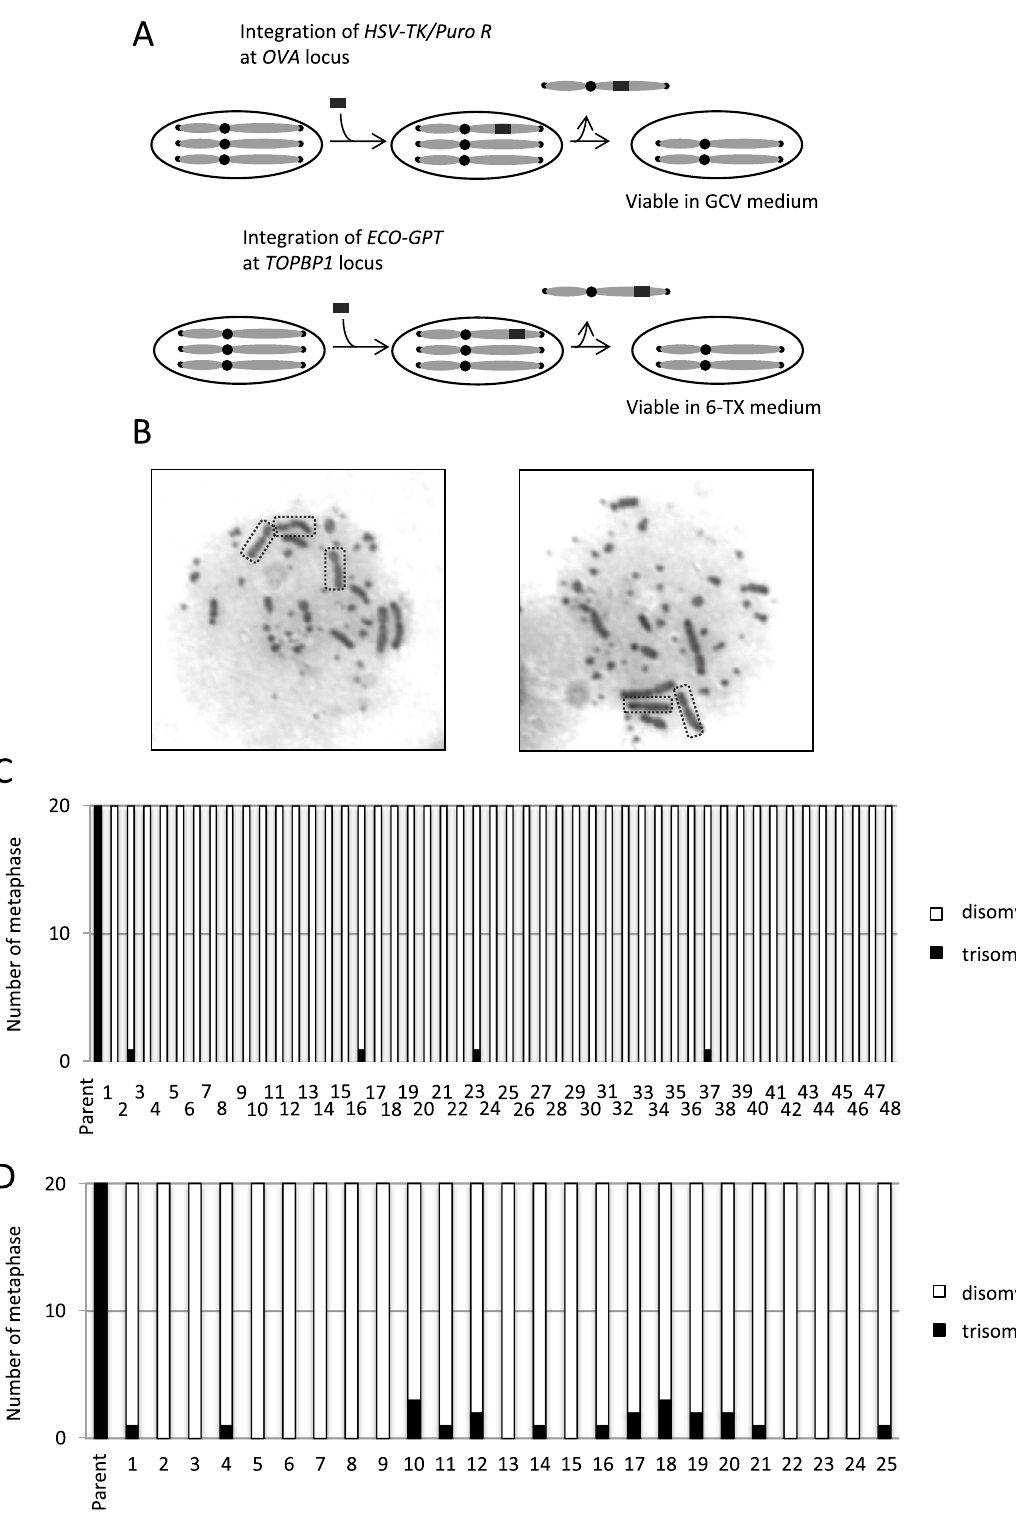
Figure 1. Correction of chromosome 2 trisomy in DT40 cells. ( A ) Schematic representation of trisomy correction with negative-selection markers. A negative-selection marker ( HSV-TK or ECO-GPT ) was integrated at OVA or TOPBP1 locus on chromosome 2 by homologous recombination. After subsequent drug selection, the cells which lost the chromosome containing negative selection marker survived. ( B ) Representative images of metaphase spreads of chromosome 2 trisomy (left) and disomy cells (right). Chromosome 2s were marked by squares. See the detail of karyotype of DT40 cells in Fig. 3B. ( C , D ) Karyotype analyses with metaphase spreads. 48 clones were picked up from 96-well plates after GCV selection ( C ) and 25 clones were picked up after 6-TX selection ( D